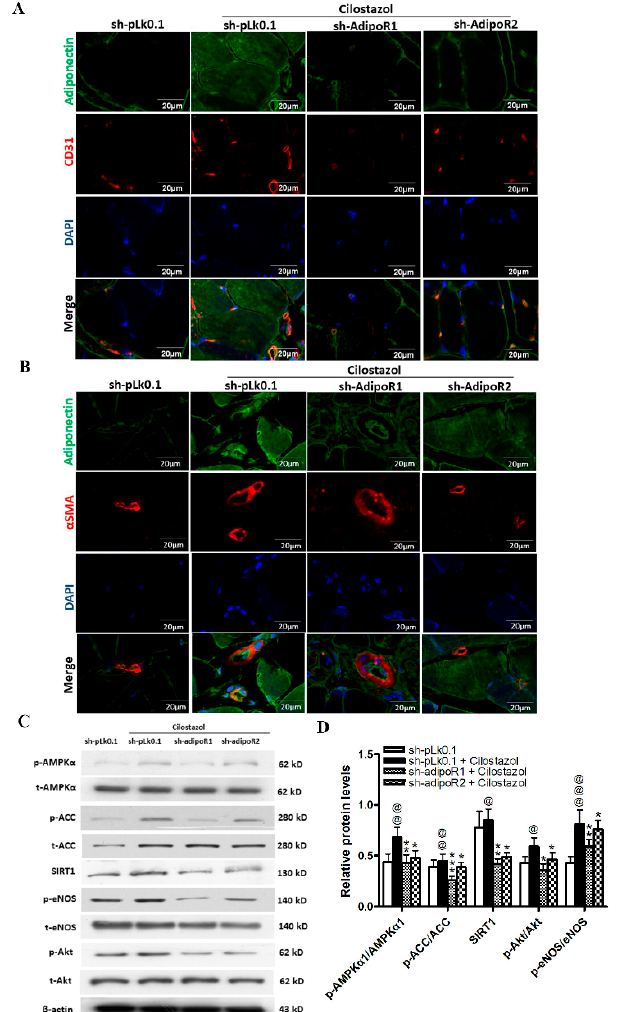
Figure 5. AdipoRs play a pivotal role in the cilostazol-mediated adiponectin angiogenesis in STZ- induced diabetic mice undergoing hindlimb ischemia. STZ-induced diabetic mice were transfected with adipoR1 sh-RNA or adipoR2 sh-RNA to knock down adipoRs. Animals were then injected with cilostazol (30 mg/kg) or vehicle twice daily for one week. ( A ) Body weight and ( B ) plasma glucose levels in the adipoR1 or adipoR2 knockdown mice. *** p < 0.001 compared with day 0. The protein expression levels of adipoR1 ( C ) and adipoR2 ( D ) were significantly decreased by plasmid transfection. ** p < 0.05 versus the control group. ( E ) Laser Doppler analysis of blood perfusion in the hindlimbs of the mice (indicated by arrows) on days 3, 7, 14, 21 and 28. ( F ) Quantification of the blood flow ratio. ( G ) Representative photomicrographs showing CD31 (red) and nuclei (blue) in ischemic muscle four weeks after femoral artery ligation. Scale bar: 50 µM. ( H ) Quantification of CD31-positive cells. ( I ) Quantification of circulating CD34 + /CD45 dim cells in mice analyzed using flow cytometry. The results are represented as the mean ± S.E.M. from five mice per group. @ p < 0.05 and @@ p < 0.01 versus the sh-pLk0.1 and vehicle-treated mice; * p < 0.05 and ** p < 0.01 versus the sh-pLk0.1 and cilostazol-treated mice.